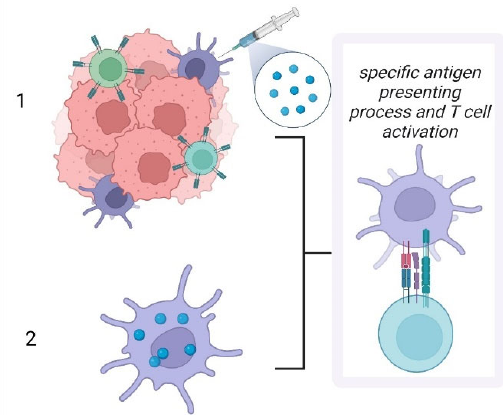
Figure 6. Therapeutic approaches using LCs. (1) In situ activation of LCs with specific antigenic peptides; (2) Ex vivo manipulation of LCs using specific antigenic peptides; both approaches induce antigen presentation enhancement and further T cell specific activation.